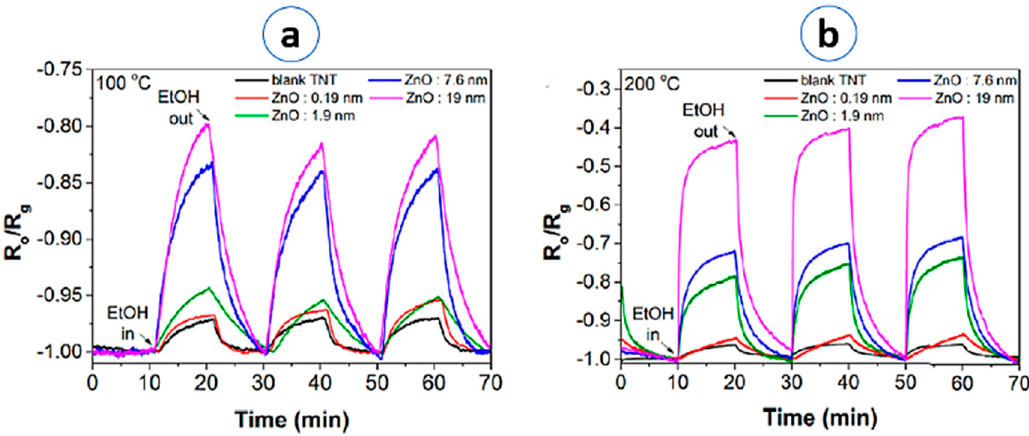
Figure 10. Ethanol sensing responses of TiO 2 NTs and TiO 2 / ZnO (0.19, 1.9, 7.6 and 19 nm) core / shell ( a ) at 100 °C and ( b ) at 200 °C. Reprinted with permission from Ref. [47] Copyright 2018 WILEY. 1D TiO 2 also showed good potentialities as NH 3 and H 2 S chemical sensors. Capability of